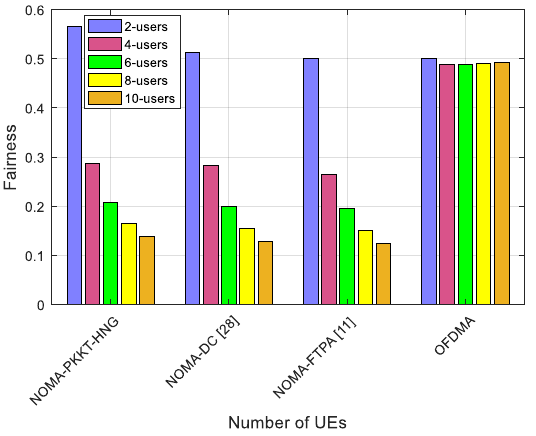
Figure 6. System energy efficiency vs. power ratio with 10 UEs.